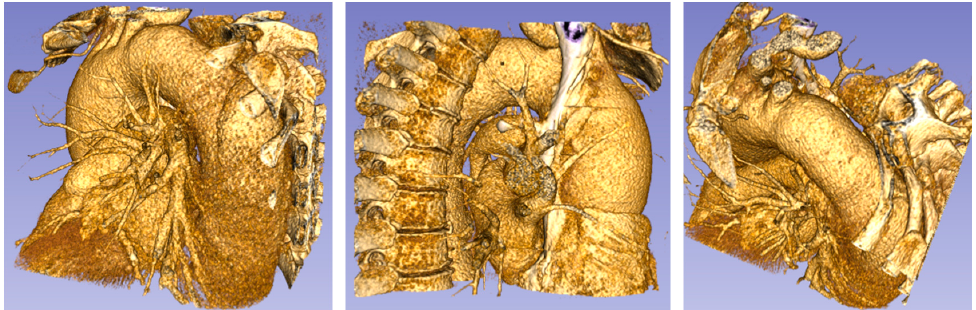
Figure 3. Patient 1 (73 years old) with a thoracic aorta aneurysm.